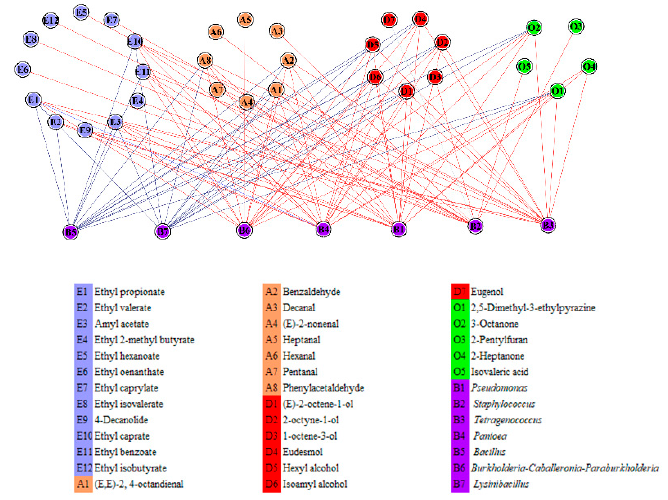
Figure 4. Correlation network analysis of characteristic flavor components and dominant genera in the early stage of sufu fermentation, the red line represents a positive correlation and the blue line represents a negative correlation.